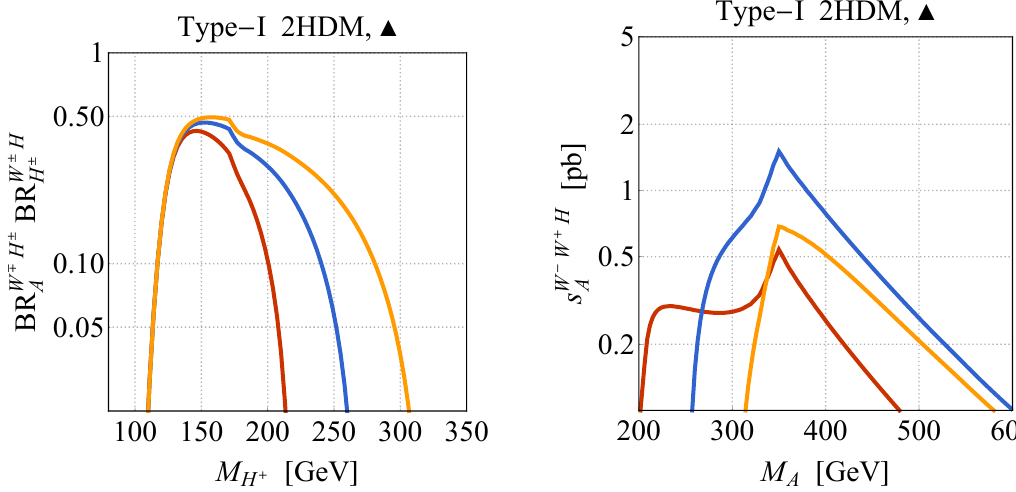
Figure 12 . Left: the product of the branching ratios A ! W ! W (cid:7) H (cid:6) and H (cid:6) (cid:6) H as a function of M H + . The red, blue and yellow curve correspond to M A = 300 GeV, 350 GeV and 400 GeV. p Right: signal strength at s = 13 TeV for pp ! A ! W (cid:0) W + H as a function of M A . The red, blue and yellow curve correspond to M H + = 120 GeV, 170 GeV and 220 GeV. All results have been obtained in the benchmark scenario